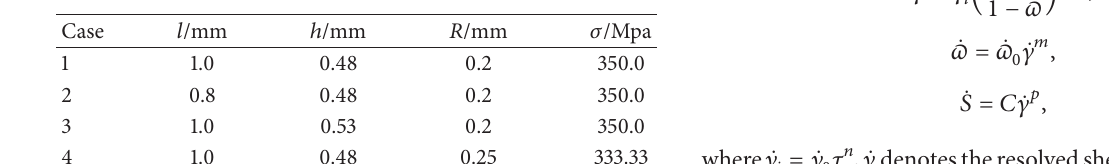
Figure 1: Schematic map of the film cooling holes geometry model. Table 1: Four cases for cooling holes creep characteristic.